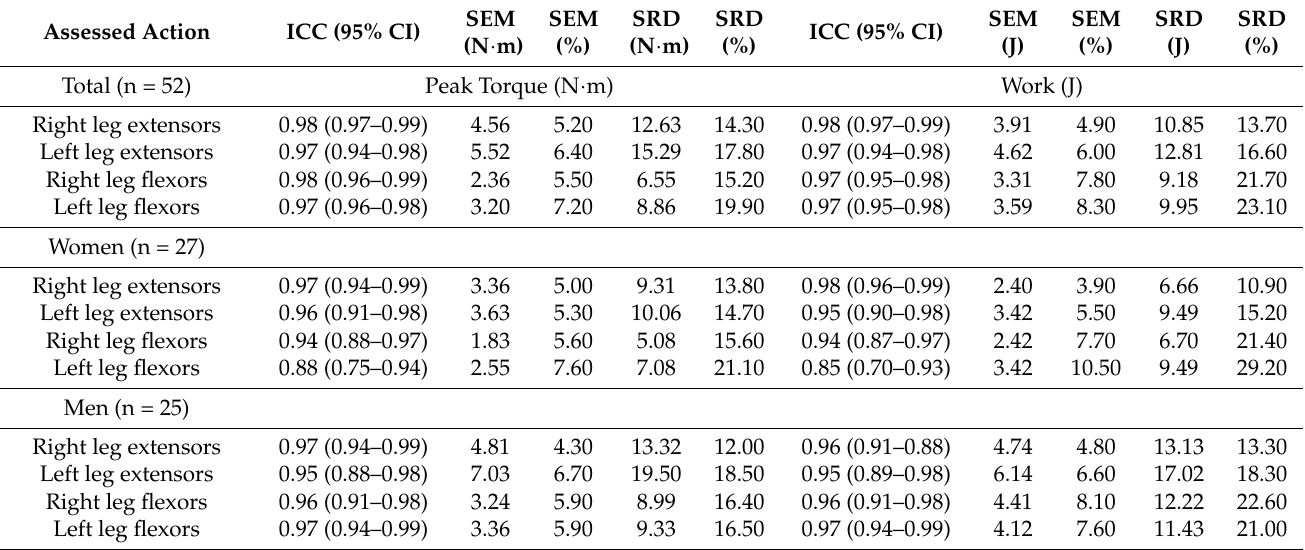
Table 3. Absolute and relative test-retest reliability of the Peak torque and Work.